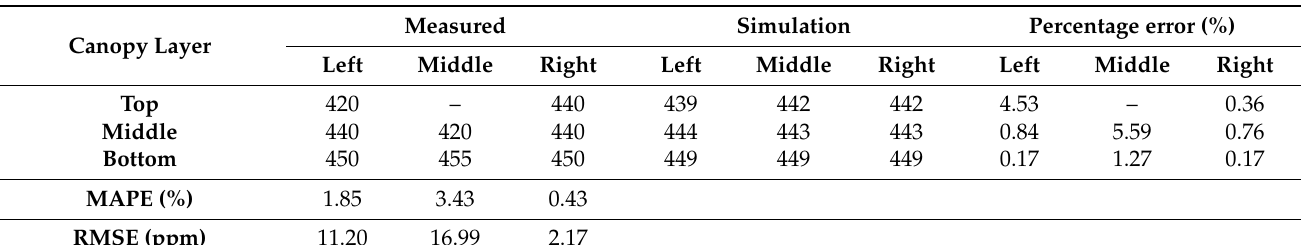
Table 3. Comparison of CO 2 concentration between measured and simulated data for model valida- tion in the chamber.